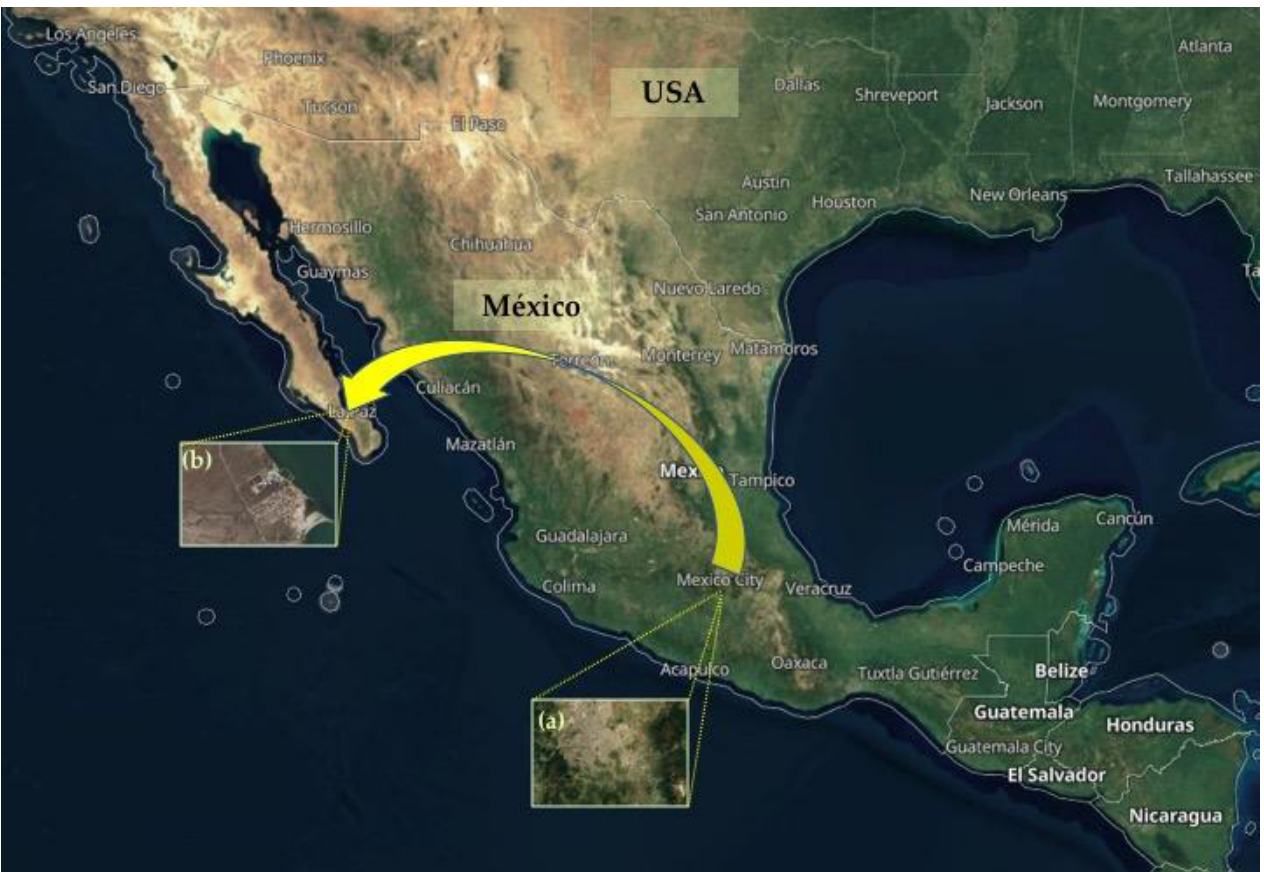
Figure 9. Geographical location of the region of: (a) Valley of Mexico, México City, and central Mexican States, where the semi-domesticated halophyte S . edulis (known as ‘R omerito ’ ) is cultivated; (b) La Paz BCS, the target locality in NW México for the introduction of S. edulis .